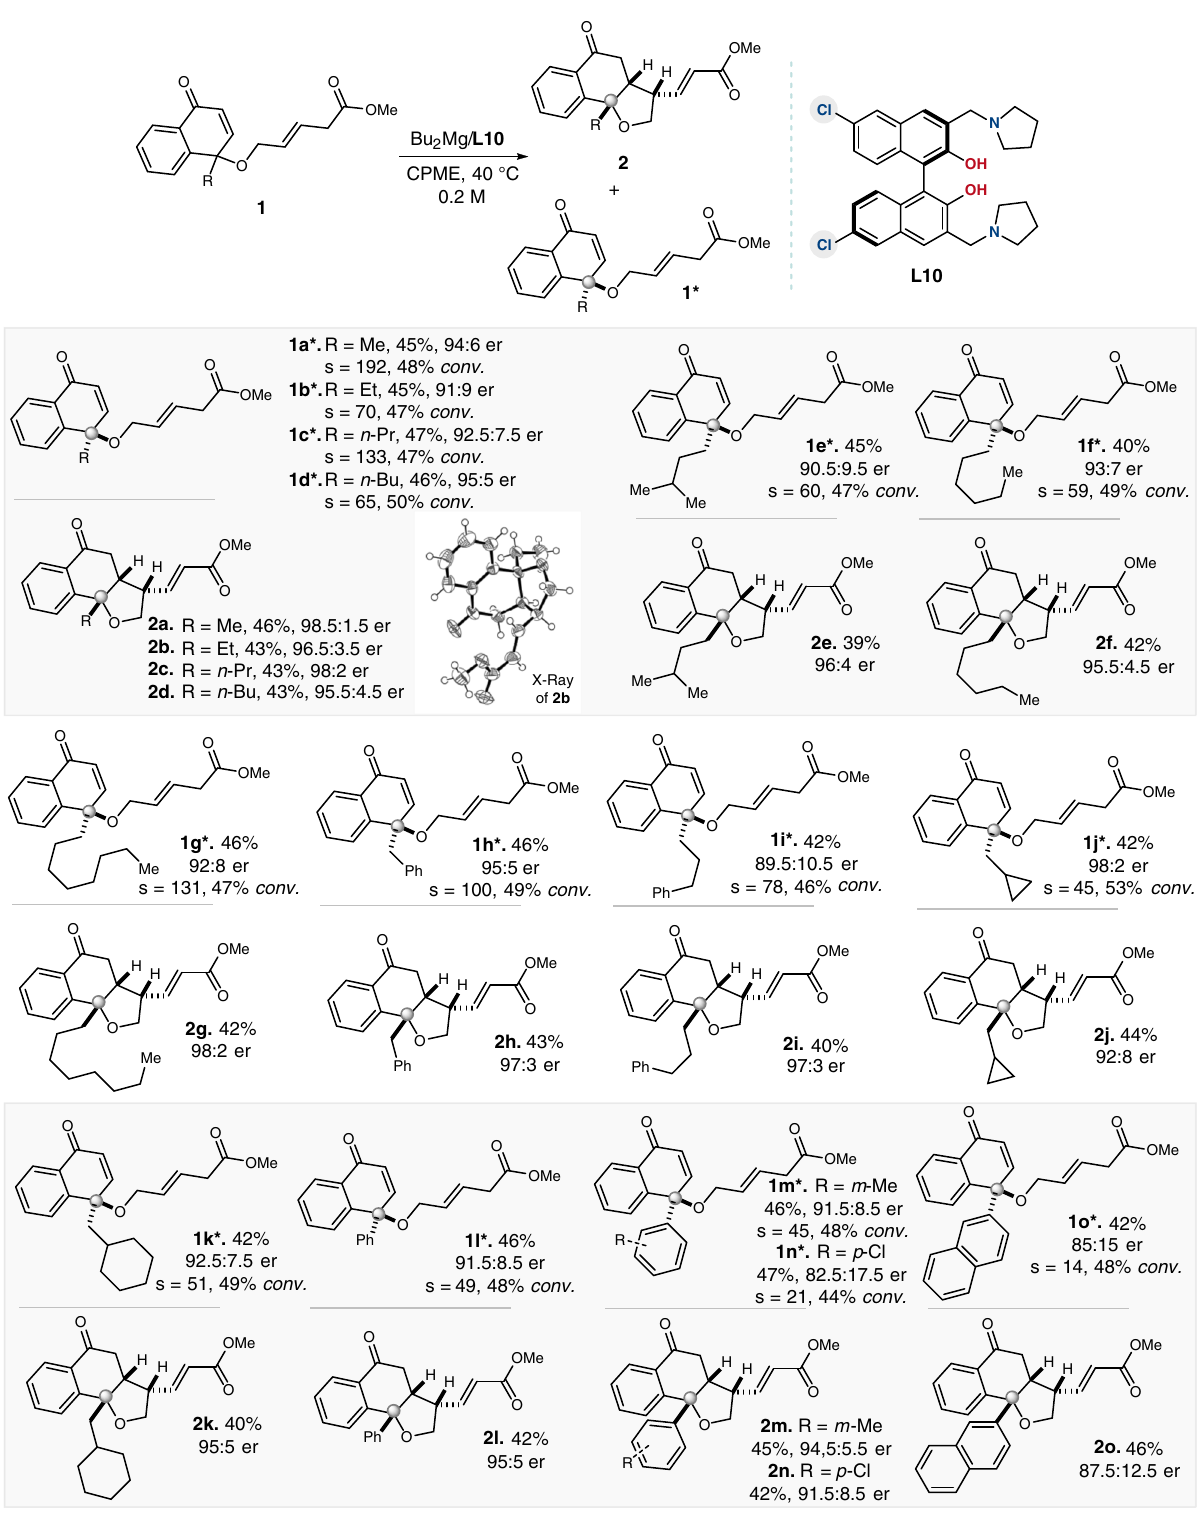
Fig. 3 Substrate scope of the KR reaction. See Supplementary Information for the detail experiment processes. All yields shown were based on isolated products. er values were determined by chiral HPLC analysis. s = ln[(1 − C)(1 − ee)]/ln[(1 − C)(1 + ee)], where ee = ee 1a* /100, ee 1a* = (R 1a* – S 1a* )/ (R 1a* + S 1a* )*100, C is monitored by HPLC analysis and calculated according to C = ee 1a* /(ee 1a* + ee 2a